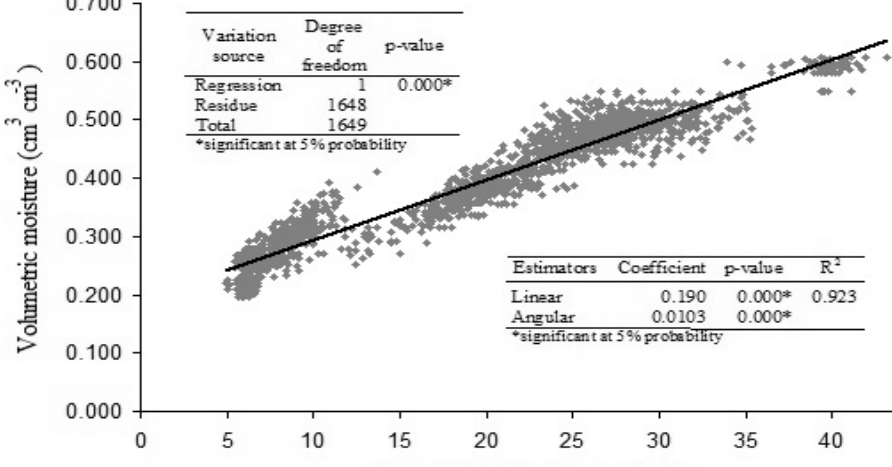
.Figure 4. Model fitted for the grouped